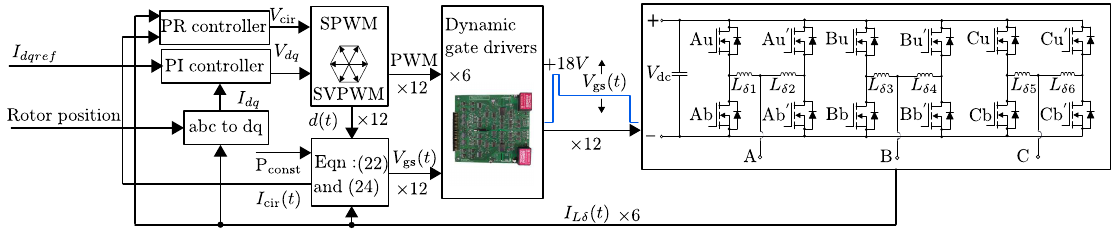
Figure 9. System operation principle of the circulation current injection